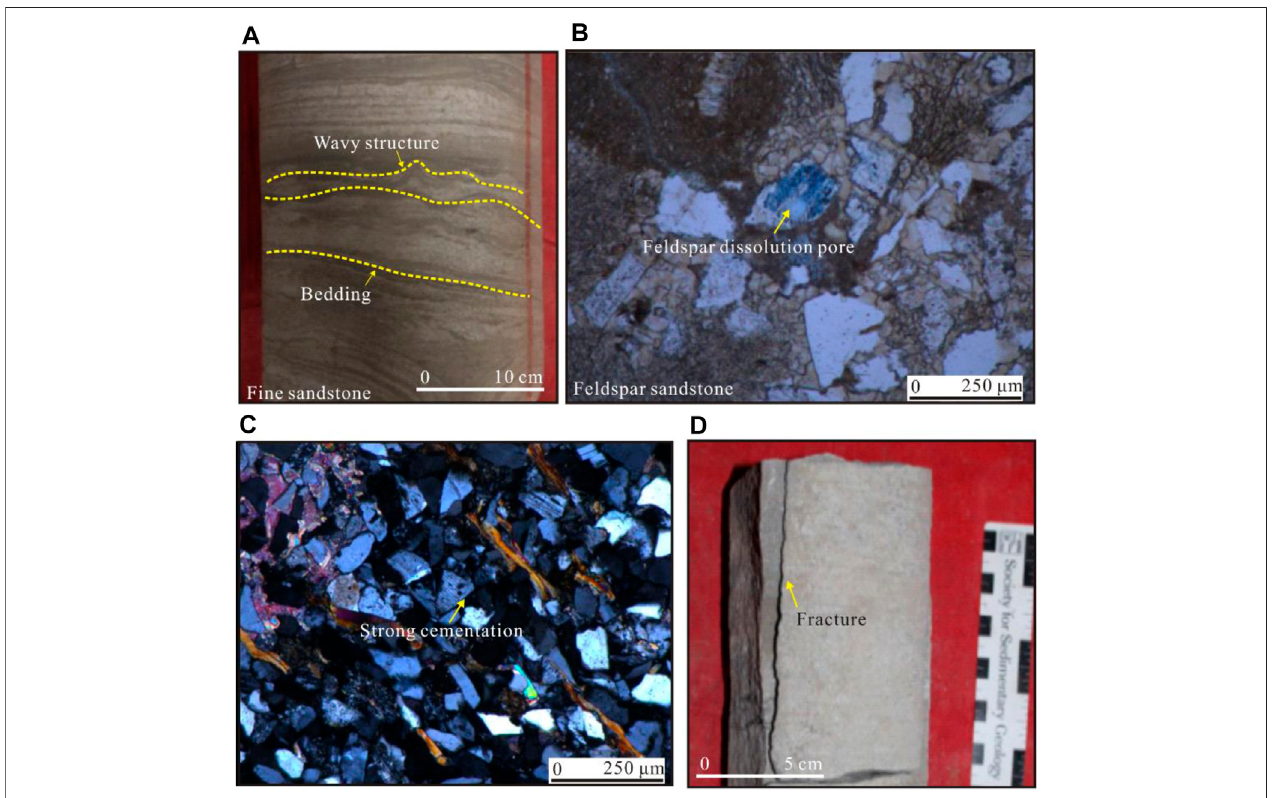
FIGURE 3 | Core and thin section observations of the target formation (Chang 6 Member) in the study area. (A) Well A1, 1707.87 m, wavy and lenticular bedding; (B) Well A2, 1840 m, feldspar dissolution pores; (C) Well B1, 1739 m, strongly cemented feldspar sandstone; (D) Well B2, 623 m, vertical fracture.